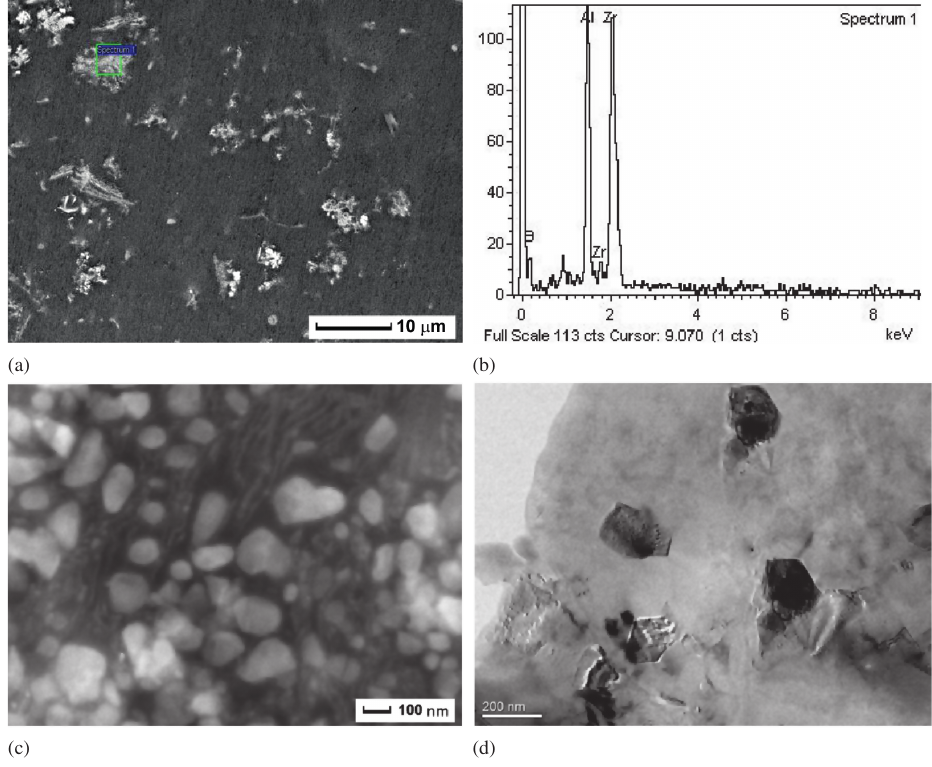
Figure 3: FESEM (a and c), TEM (d) and EDS pattern (b) of in situ ZrB 2 particle reinforcement